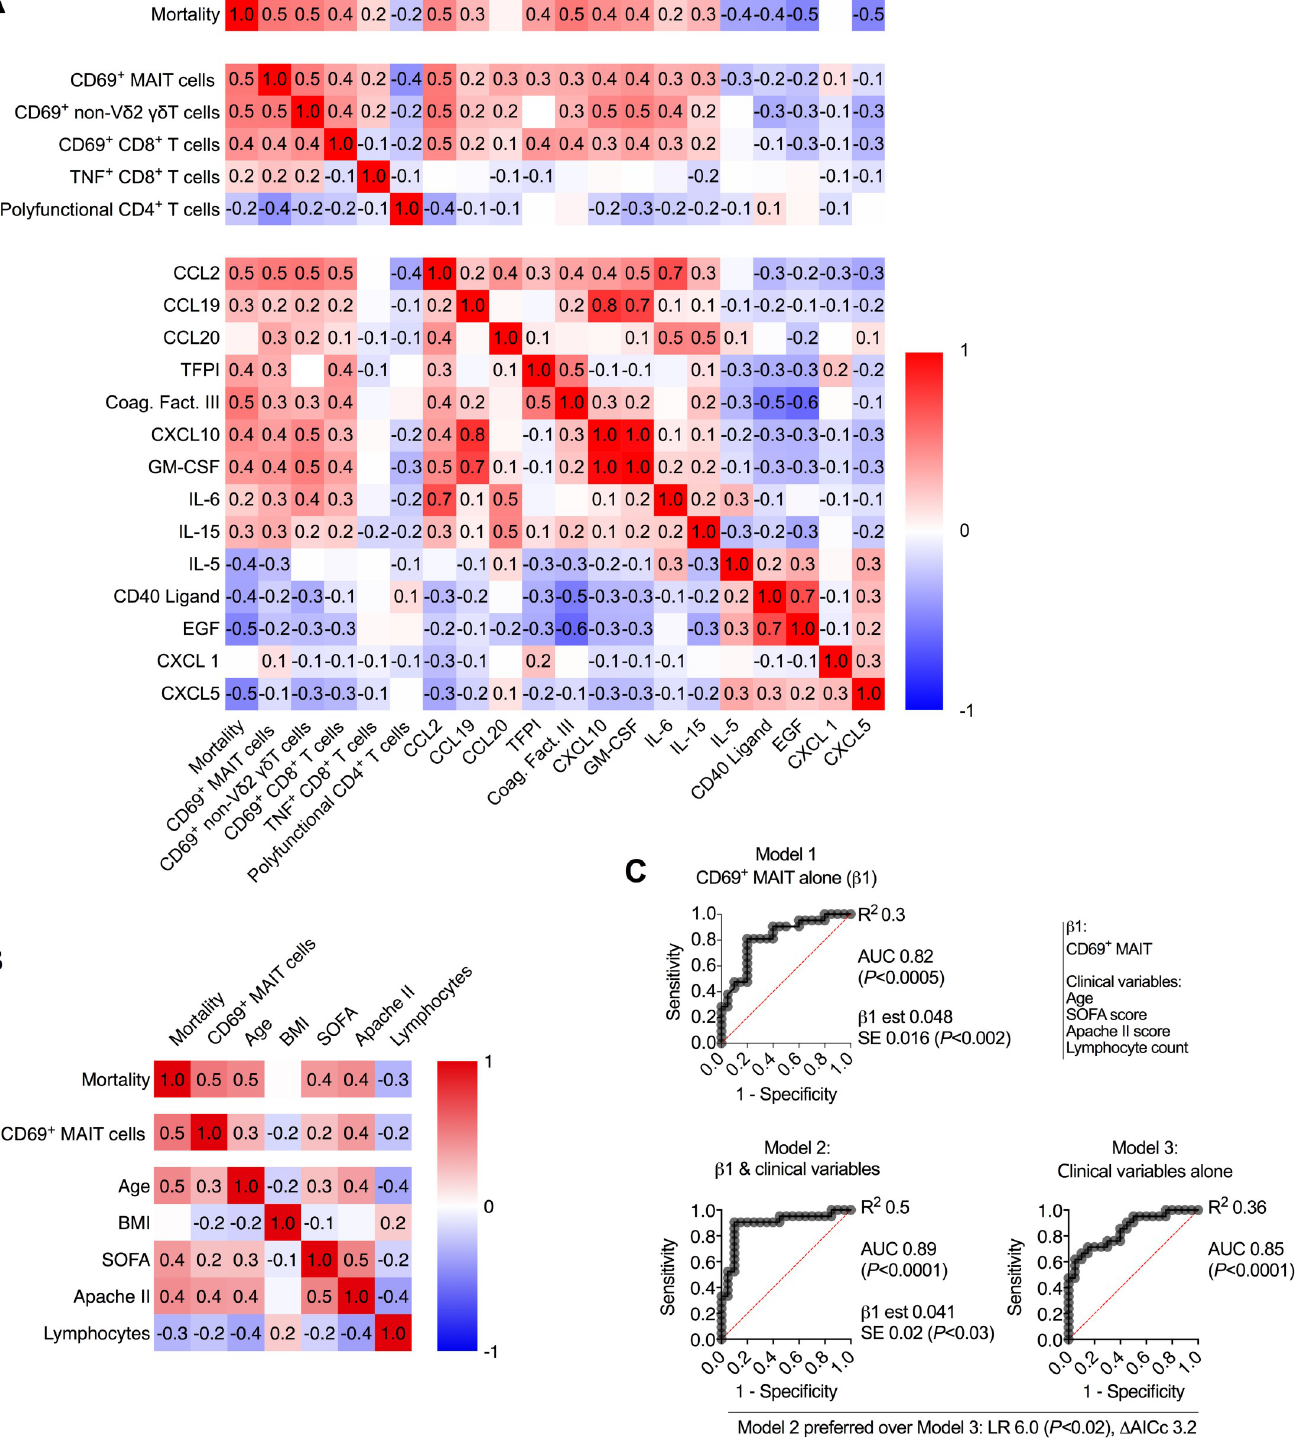
PLOS Pathogens| https://doi.org/10.1371/journal.ppat.1009804 September 16, 2021 13 /